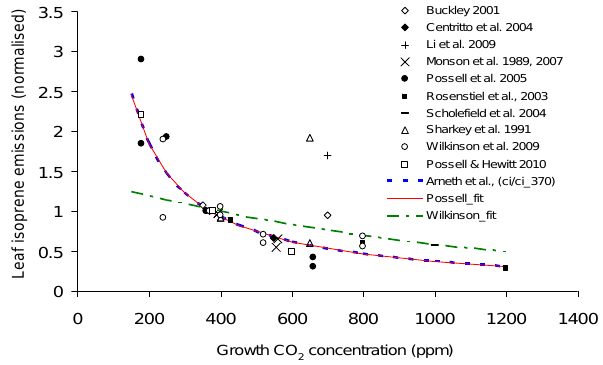
Fig. 6. Leaf-level response of isoprene emissions to varying CO 2 growth environment. Symbols represent observations from a num- ber of studies and plant species, and are normalised to be unity at growth CO 2 concentration ( C a ) of c 370ppm. Data shown are only from emission measurements that were undertaken at the CO 2 growth concentration. The lines represent three different algorithms that are currently being applied to represent the observed response in global models: (i) the empirical function proposed by Possell et al. (2005), used e.g., for BVOCEM in (Lathi`ere et al., 2010); (ii) a function representing the ratio of change in (non water-stressed) leaf-internal CO 2 concentration ( C i ) to C i at 370ppm, used e.g., for LPJ-GUESS in ( C i / C i − 370 ; Arneth et al., 2007a), which can be in- terpreted as reflecting the varying leaf-internal competition for CO 2 (Rosenstiel et al., 2004) – this line is by chance nearly identical to the empirical function in (i); (iii) a “Hill”-type function proposed by Wilkinson et al. (2009), with C i estimated as 0.7 × C a in anal- ogy to the same assumption applied in LPJ-GUESS (Arneth et al., 2007b). Approach (iii) has been adopted for MEGAN e.g., in Heald et al. (2009). The Figure is adapted from Young et al. (2009), and updated with latest published